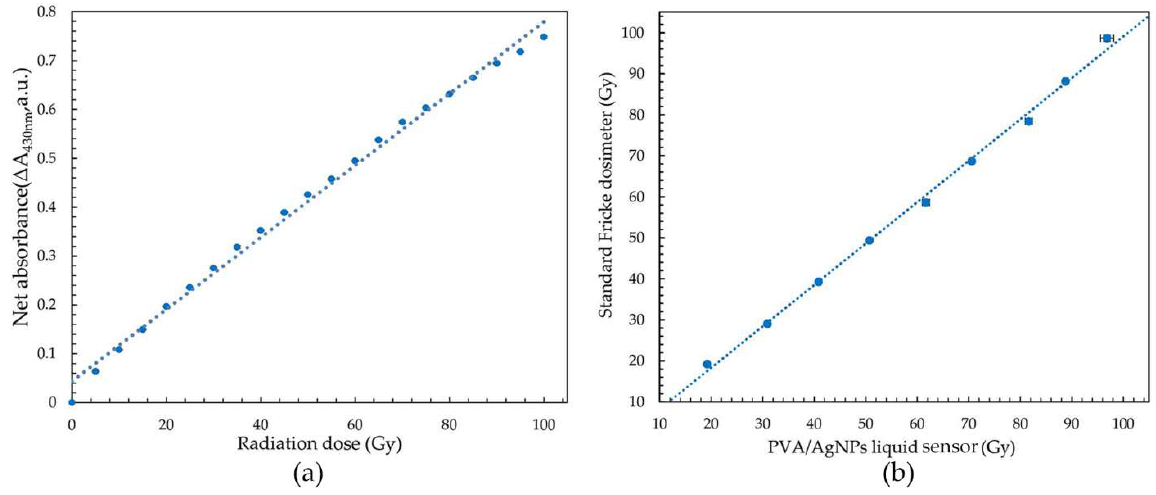
Figure 5. ( a ) Calibration curve of the optimized PVA/AgNPs sensor, and ( b ) the intra-class correlation coefficient (ICC) of the PVA/AgNPs sensor and standard Fricke dosimeter. The accuracy of dose measurements was estimated by the comparison with those from a standard Fricke dosimeter. Estimates were done in the range of 20 to 100 Gy, in